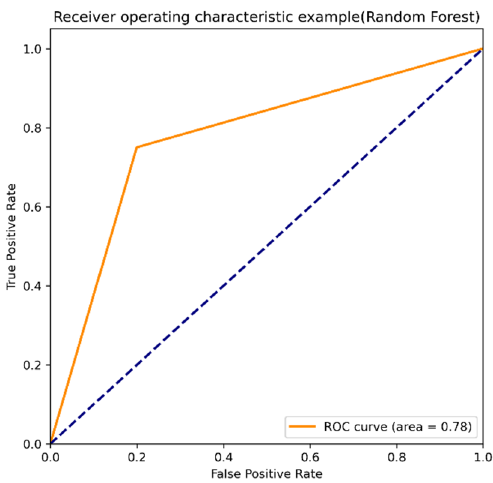
Figure 5. ROC in Soochow direction. Figure 3. ROC in Soochow